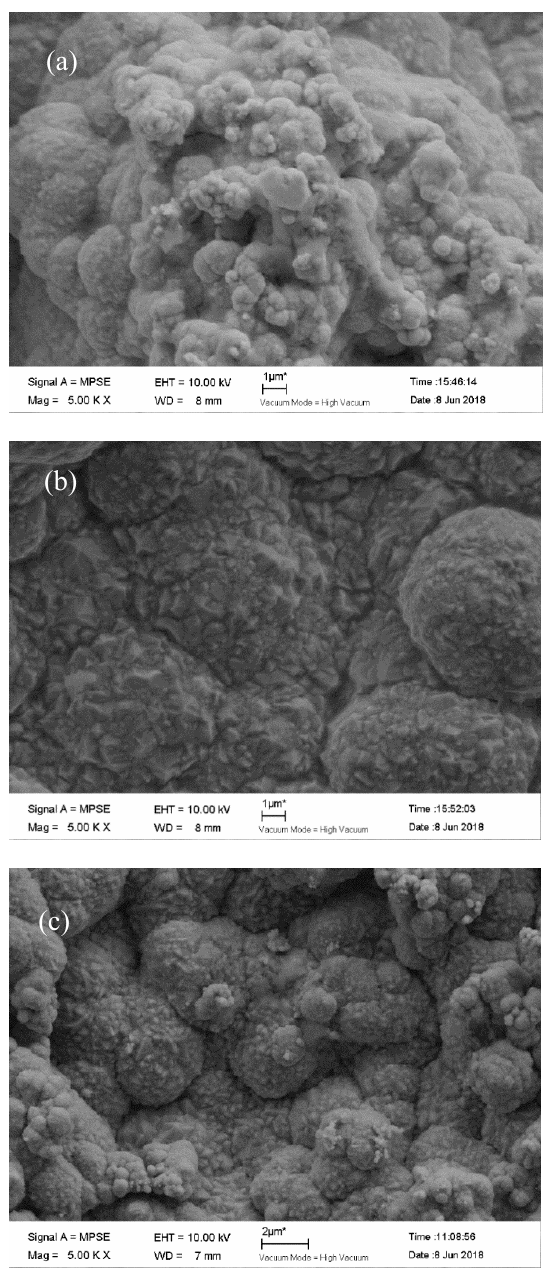
Figure 8. Micrographs of composite coatings prepared by different reverse duty cycles (×5000): ( a ) 0.1, ( b ) 0.2, ( c ) 0.3.